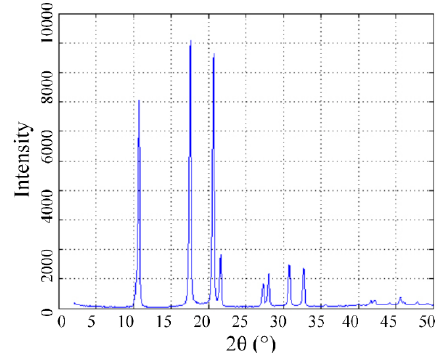
Table 1. Basic physicochemical properties of insulating liquid.